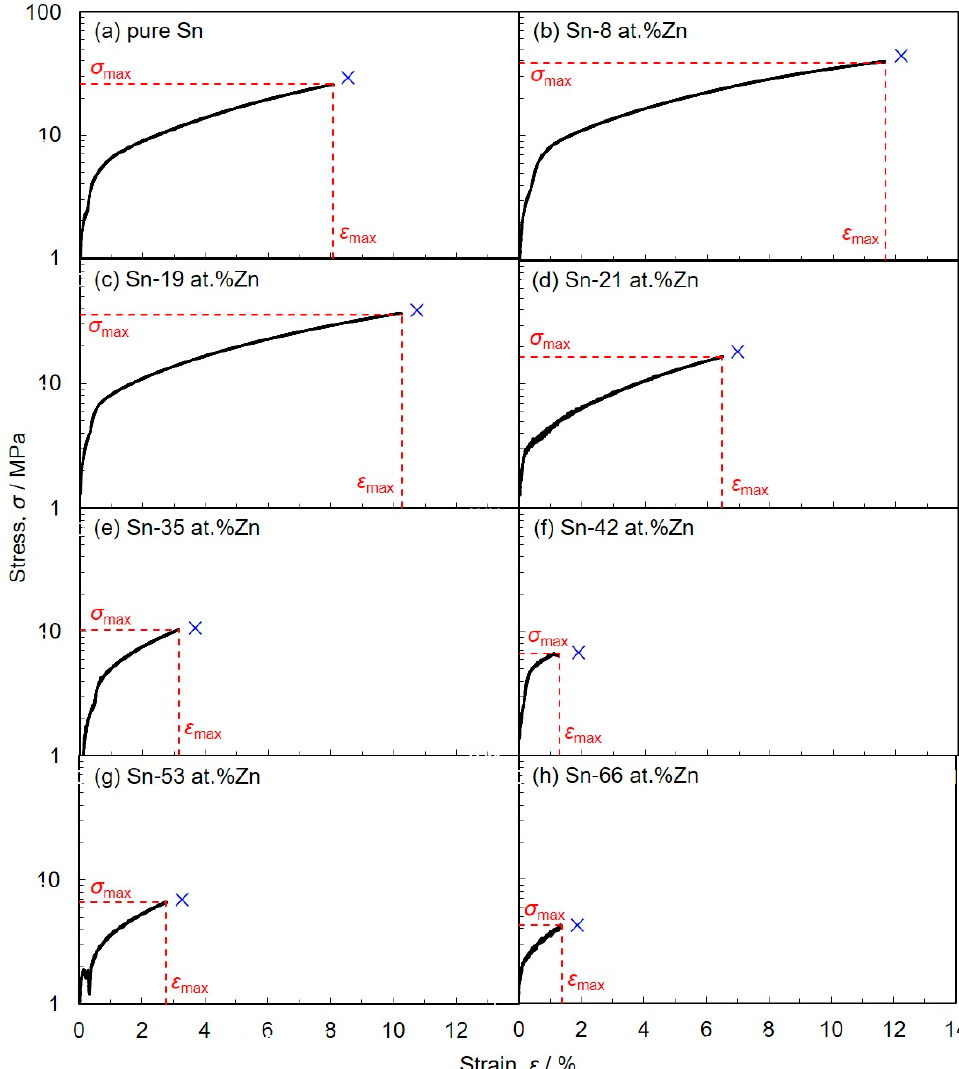
Figure 9. Stress–strain curves obtained from butt-jointed copper rods which were soldered with electrodeposited Sn-Zn alloy films. (Zn content: ( a ) 0 at.%, ( b ) 8 at.%, ( c ) 19 at.%, ( d ) 21 at.%, ( e ) 35 at.%, ( f ) 42 at.%, ( g ) 53 at.%, ( h ) 66 at.%)